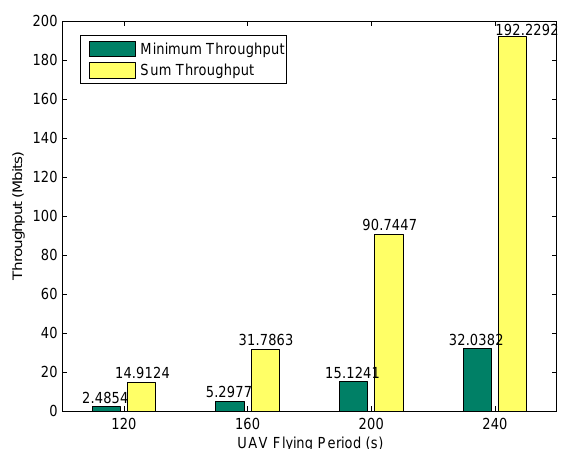
Figure 8. Performance comparison of different periods T for the case B k [ 0 ] > 0.